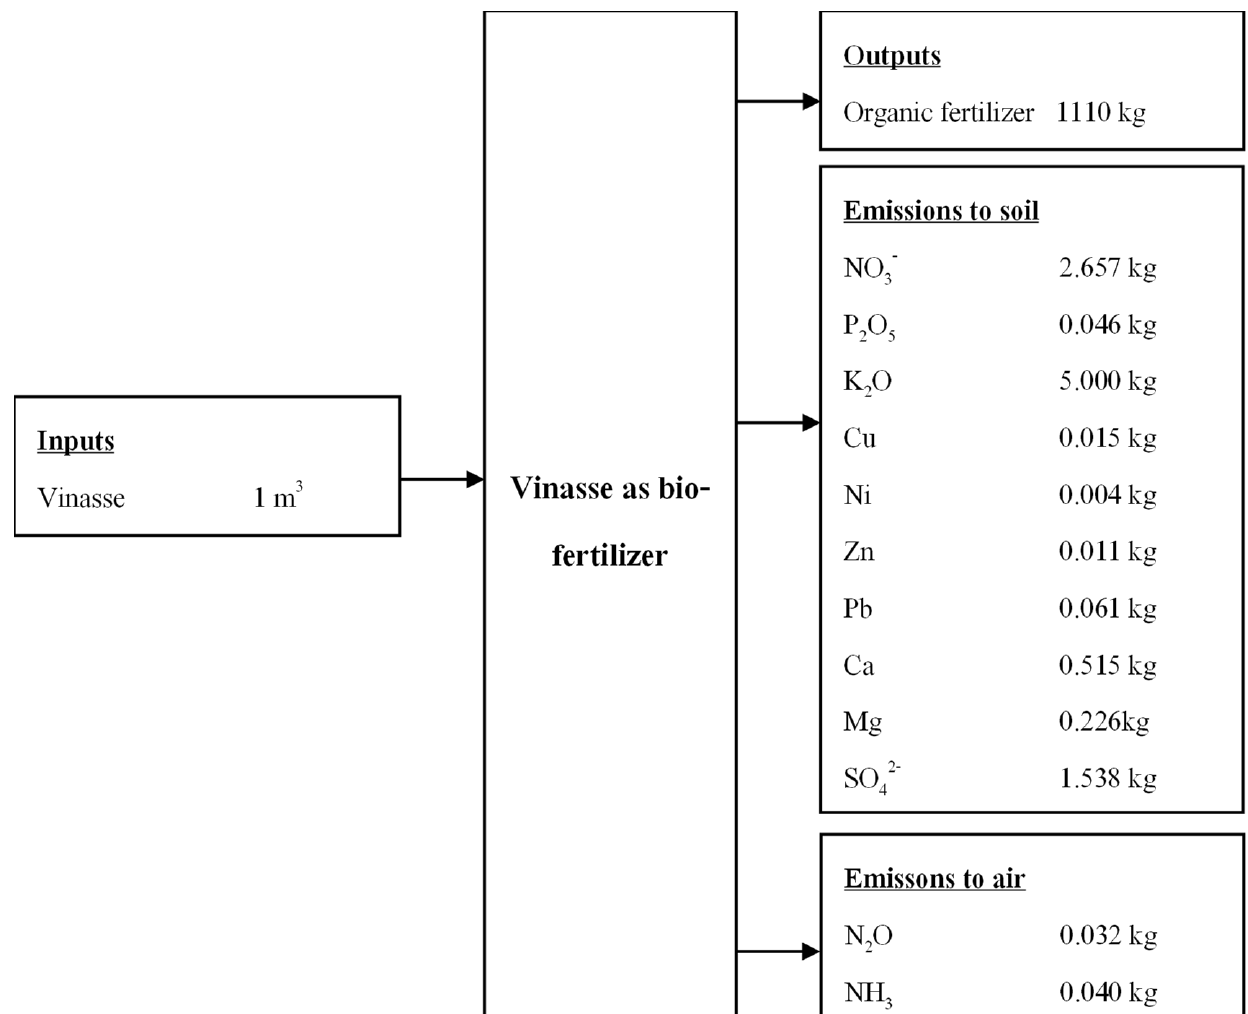
Figure A6. Inputs-Outputs of Scenario V1: Vinasse as bio-fertilizer (V1). Remark: Organic fertilizer production is referred from [55]; Emissions to soil are referred from [66,67]; Emissions to air are referred from [68].